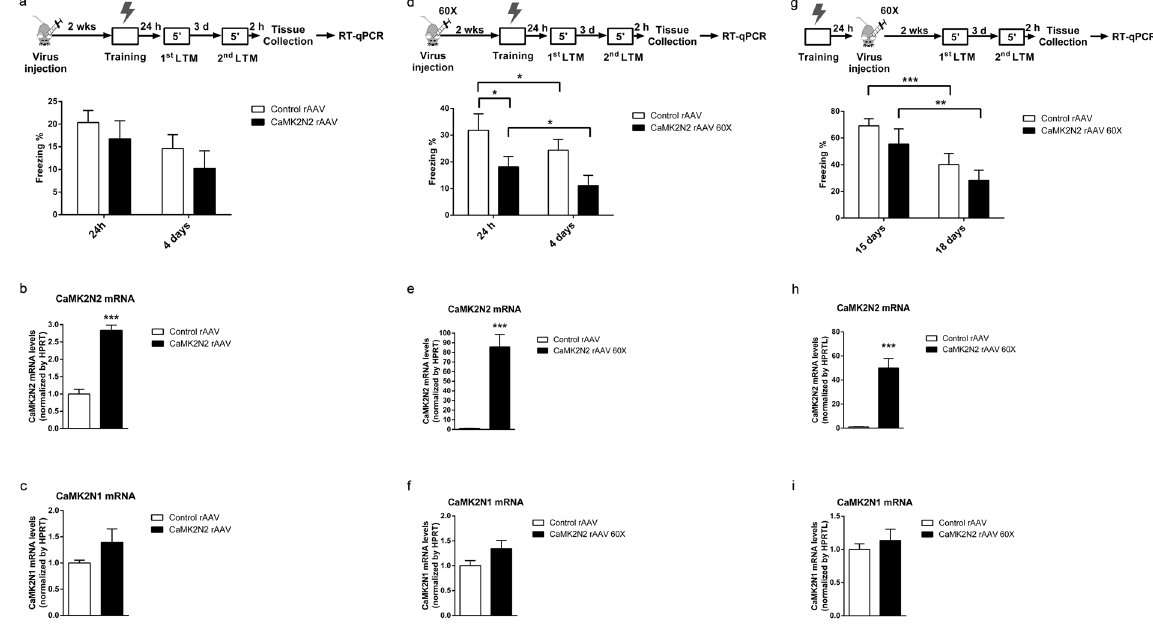
Figure 4. Overexpression of CaMK2N2 in dorsal hippocampi impairs memory formation but does not impair contextual fear LTM maintenance. ( a ) Dorsal hippocampi of mice were transfected with rAAV expressing either ZsGreen (n = 13) or CaMK2N2 (n = 11) under control of a synapsin 1 promoter. Contextual fear LTM was determined one day and 4 days after conditioning. No significant difference was observed. ( b ) Mice studied in ( a ) overexpressed CaMK2N2 mRNA in dorsal hippocampus (Control rAAV, n = 11; CaMK2N2 rAAV, n = 10). ( c ) Overexpression of CaMK2N2 mRNA did not alter CaMK2N1 mRNA levels (Control rAAV, n = 9; CaMK2N2 rAAV, n = 9). ( d ) Another cohort of animals was subjected to the same experimental design as in ( a ) with the exception that these animals were treated with a 60x more concentrated version of the CaMK2N2 rAAV solution (1.07 × 10 13 GC/ml). In these mice CaMK2N2 overexpression reduced freezing scores in the first memory test, indicating impaired memory formation (Control rAAV, n = 11; CaMK2N2 rAAV, n = 10). ( e ) RT-qPCR analysis confirms effective overexpression of CaMK2N2 in dorsal hippocampi of CaMK2N2 rAAV 60x animals (n = 10) compared to Control rAAV (n = 11). ( f ) CaMK2N2 rAAV 60x treatment did not affect CaMK2N1 mRNA levels (Control rAAV, n = 11; CaMK2N2 rAAV, n = 10). ( g ) A final cohort of animals was first conditioned in the CFC paradigm and 24 hours later treated with the 60x CaMK2N2 rAAV solution. A period of 2 weeks was waited to allow the genetic information from the vector to be expressed, after which the fear memory of the context was tested twice. The two tests were apart from each other by 3 days, therefore they were executed 15 days and 18 days after CFC conditioning. No significant effect of 60x CaMK2N2 rAAV treatment was observed in the freezing behavior (Control rAAV, n = 8; CaMK2N2 rAAV, n = 7). ( h ) CaMK2N2 mRNA levels were increased after 60x CaMK2N2 rAAV treatment (Control rAAV, n = 8; CaMK2N2 rAAV, n = 7). ( i ) CaMK2N2 overexpression did not affect CaMK2N1 mRNA levels (Control rAAV, n = 8; CaMK2N2 rAAV, n = 7). Mean and S.E.M.; * P < 0.05; ** P < 0.01; *** P <